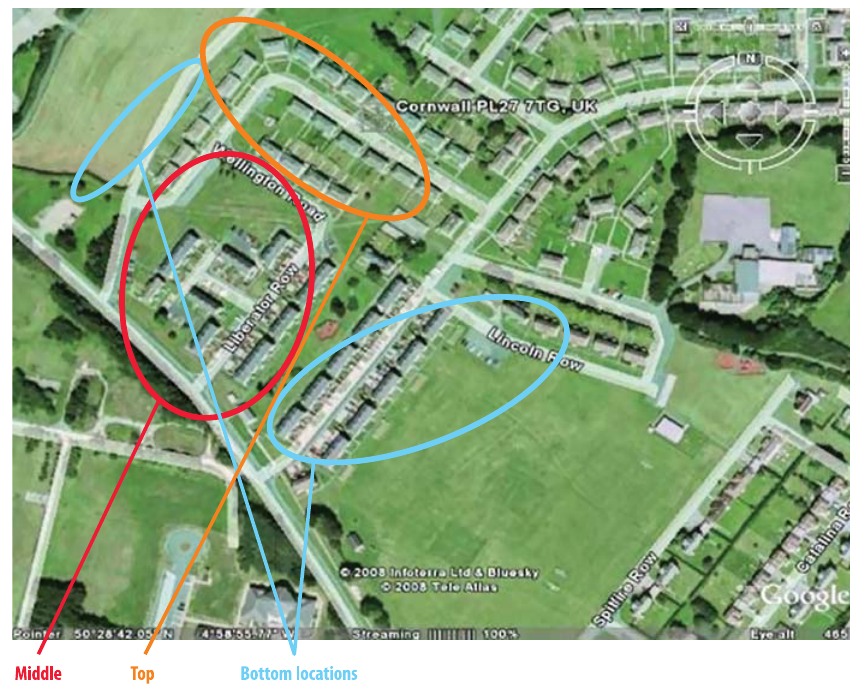
Figure 6. Aerial view of houses in St Eval showing the 3 locations in the sample (top, middle and bottom) according to price